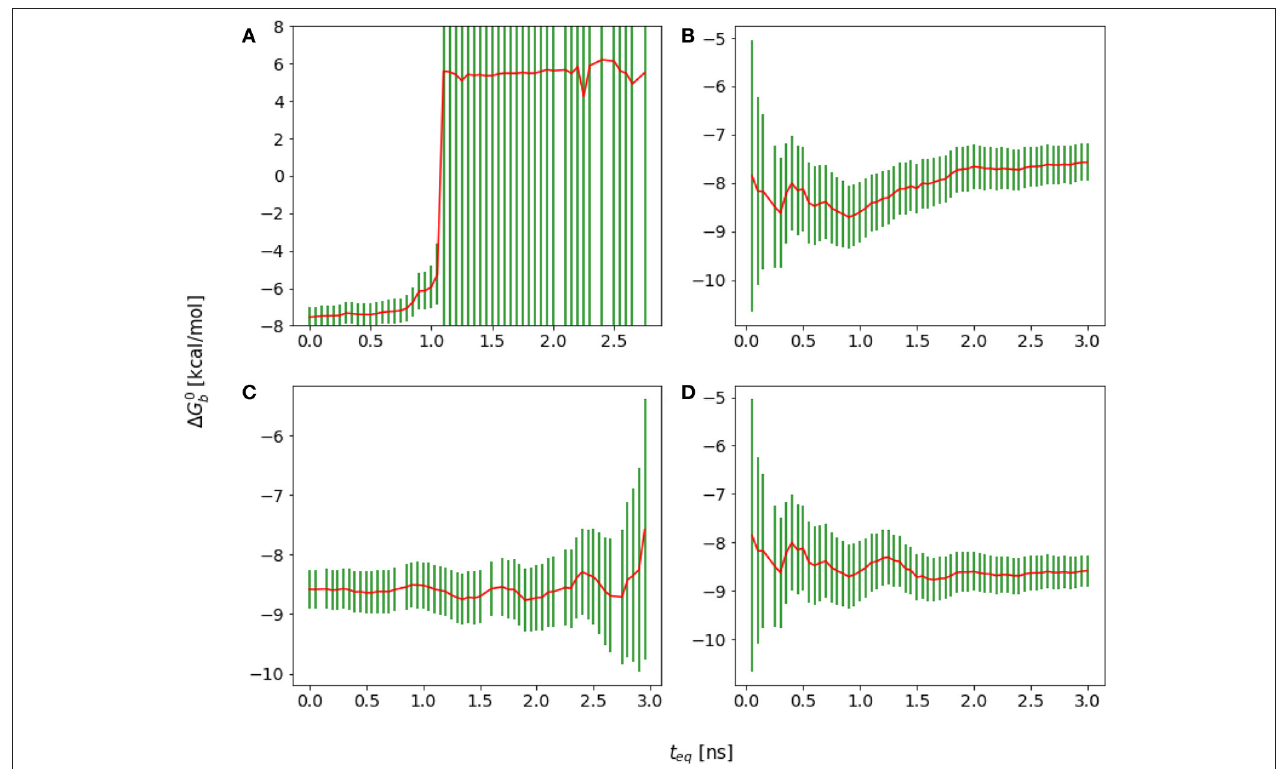
FIGURE 9 | Cumulative plots for the wildtype cyclic peptide. (A) Reverse cumulative and (B) forward cumulative plots obtained with the original smaller lambda schedule. (C) Reverse cumulative and (D) forward cumulative plots of the data with the improved lambda schedule. Notice that when there is no equilibrium bias the forward and reverse plots are near mirror images.